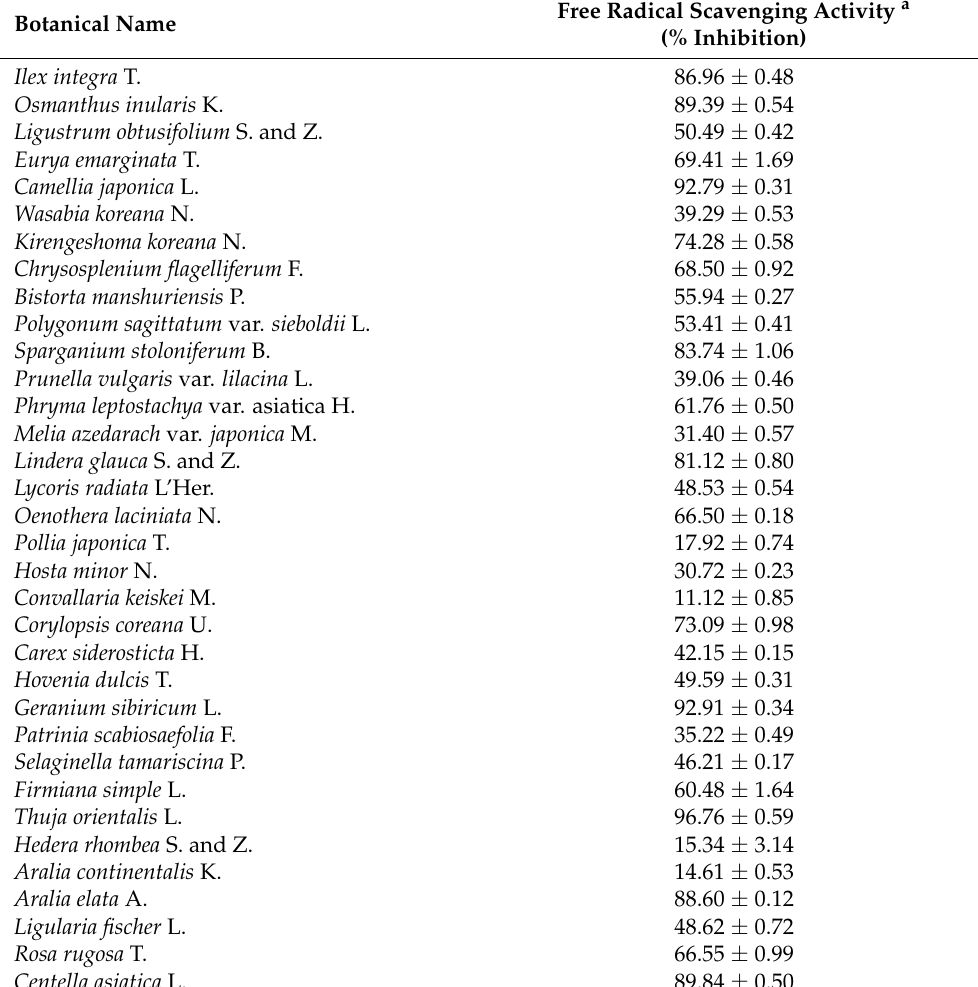
Table 2. DPPH free radical scavenging activities of plant